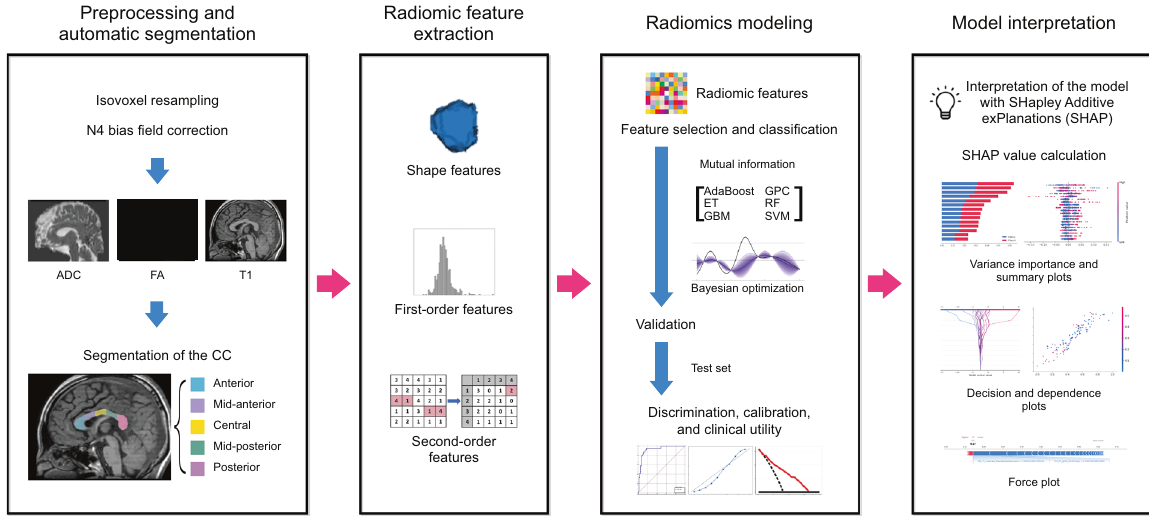
Fig. 1 Work fl ow of image preprocessing, radiomics feature extraction, and machine learning. ADC apparent diffusion coef fi cient, FA fractional anisotropy, T1 T1-weighted image, CC corpus callosum, ET extra trees, GBM gradient boosting machine, GPC Gaussian process classi fi cation, RF random forest, SVM support vector